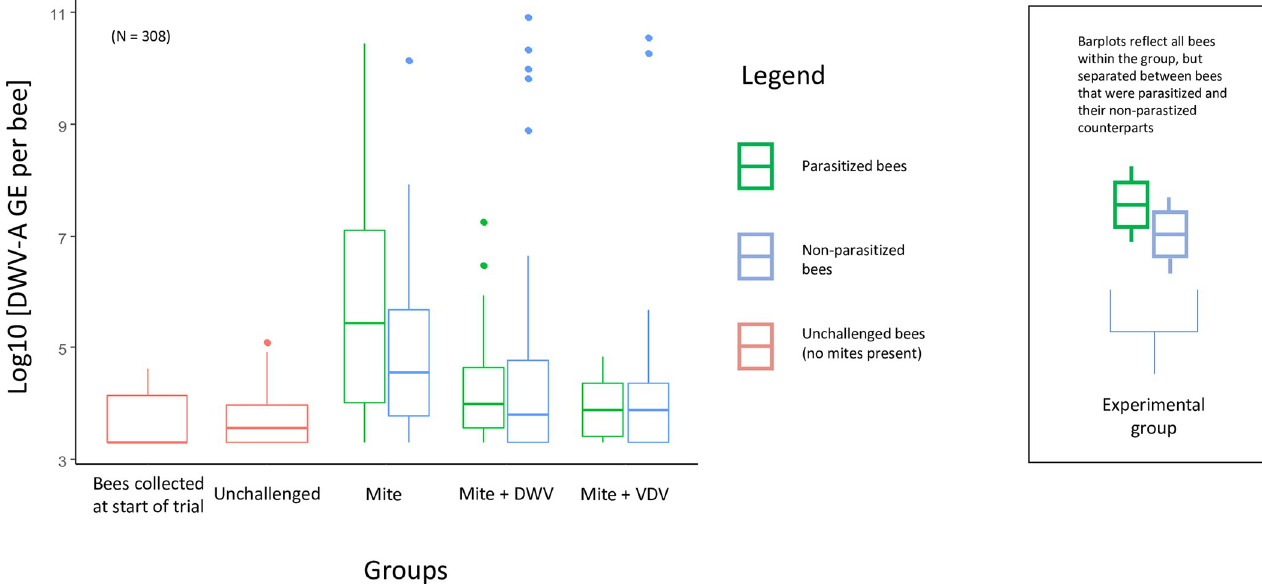
Fig 5. DWV-A genome equivalents (GE) per bee loads of 308 individual bees sampled from experiment 4. The four treatment groups are shown, as well as an additional group (furthest left) of bees collected at the start of the trial. For the 3 Varroa challenged groups, dual boxplots were used to display DWV-A GE per bee separately for parasitized and non-parasitized bees. The relative proportion of parasitized to non-parasitized bees can be found in Table 5 and AOV analysis from Tables A-D in S1 Tables .